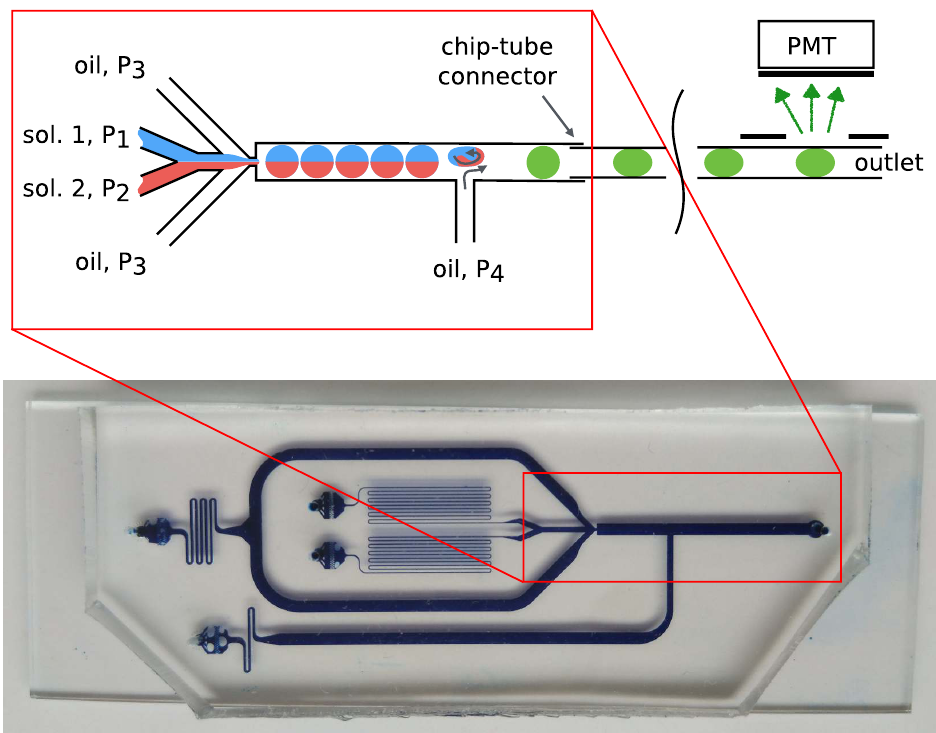
Figure 1. The microfluidic chip with dye in channels and the scheme of